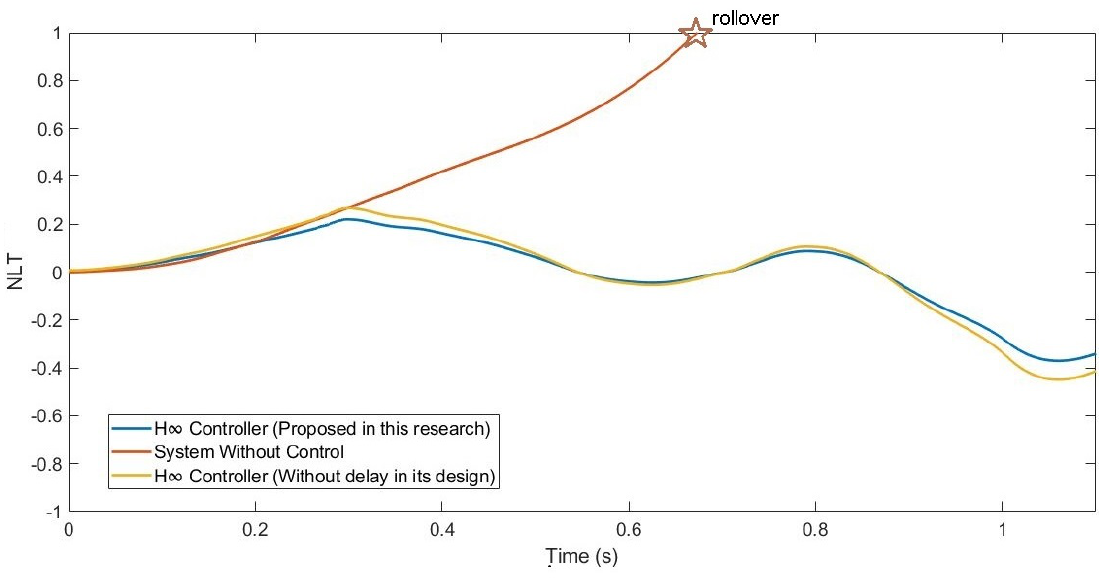
Figure 24. NLT of rear axle for test 3: Roundabout at 120